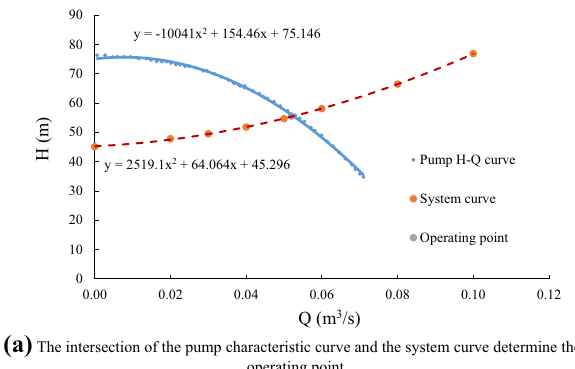
(a) The intersection of the pump characteristic curve and the system curve determine the operating point